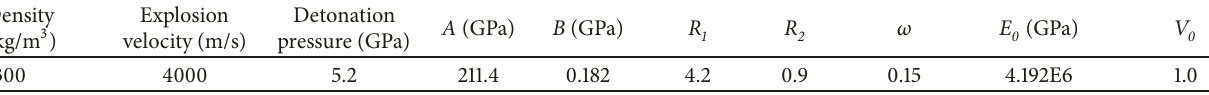
Table 5: Material model and state equation parameters of the explosive.